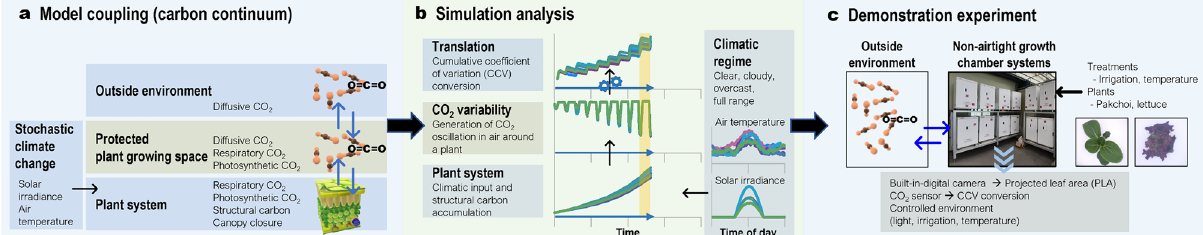
Figure 1. Overall workflow and potential application of CO 2 variability translation ( a ) coupled model for CO 2 fluxes between the system outside-plant growth system-plant continuum and stochastic climatic inputs. ( b ) Simulation analysis procedure to translate CO 2 variability in the plant growth system air into a progress curve displaying environment-plant dynamic interaction and biophysical constraints by cumulative coefficient of variation (CCV) conversion. ( c ) Experimental conditions to demonstrate CCV behaviors under non-airtight growth chamber